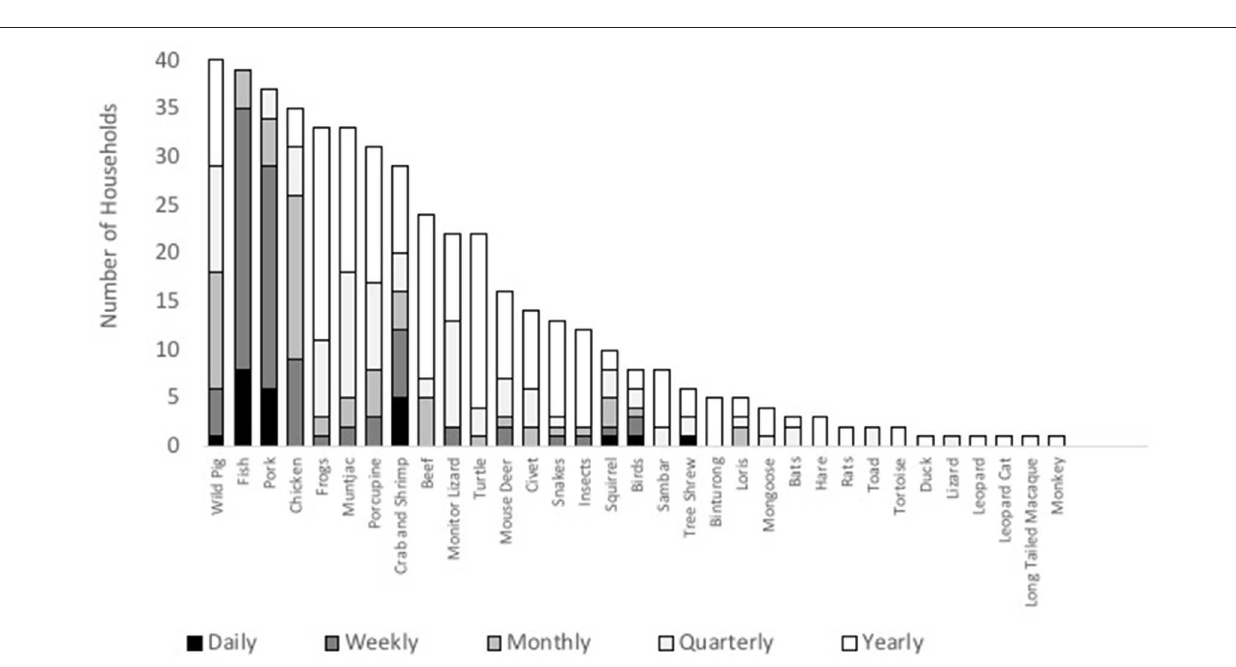
FIGURE 5 | Frequency of consumption for wild and domestic species ( n = 40